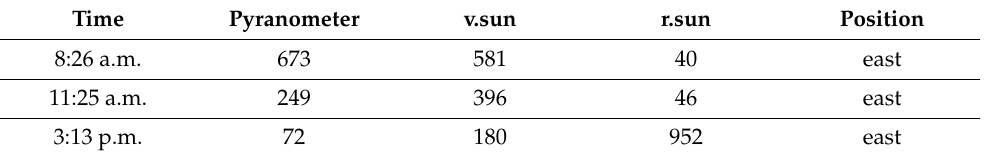
Table 1. Solar irradiance at the apartment house in Československá street in W/m 2 on 23 June 2021.